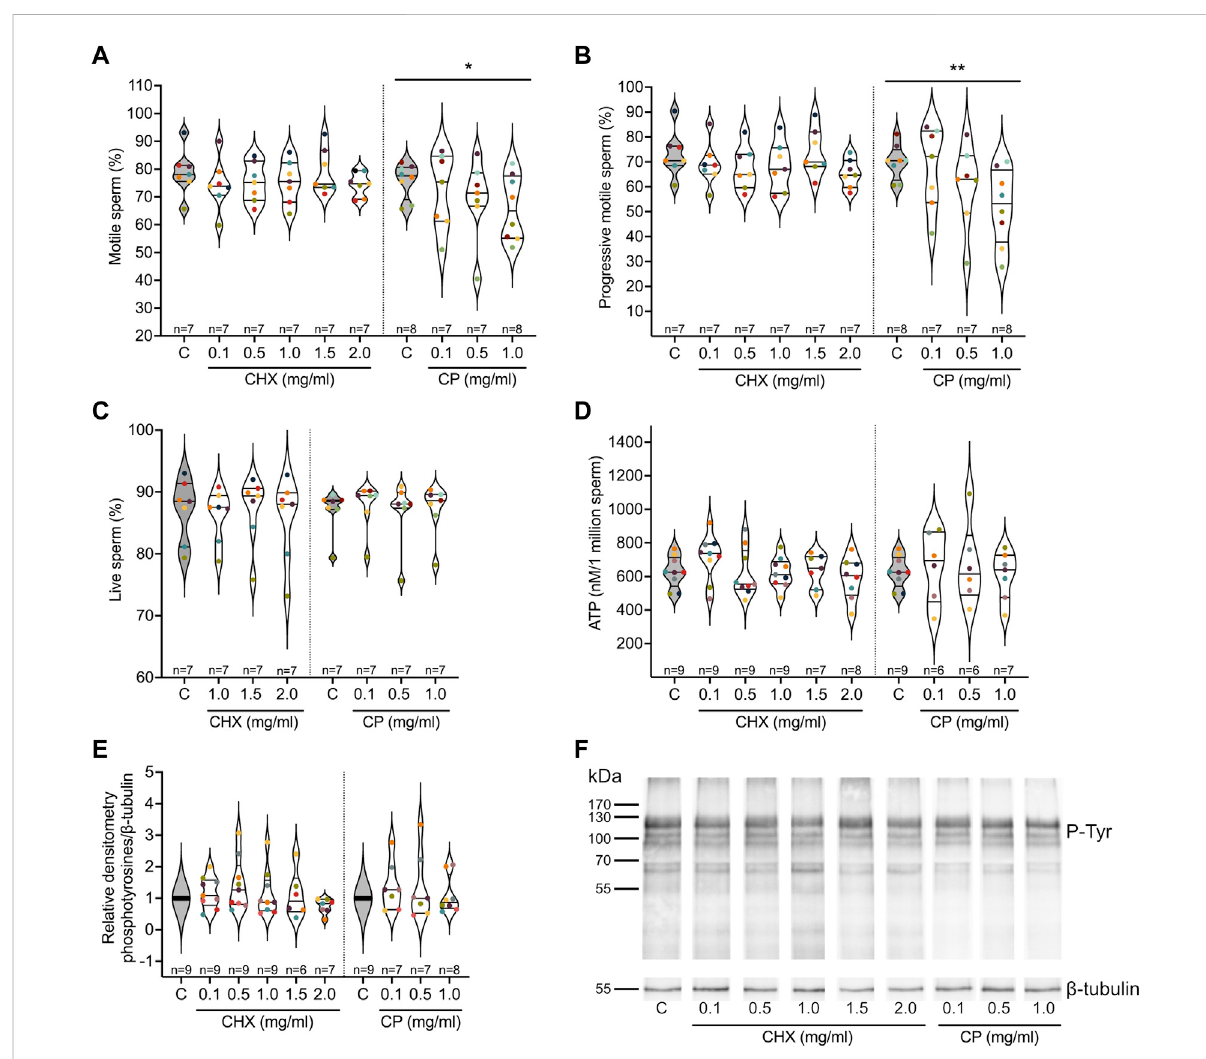
FIGURE 3 In fl uence of cytoplasmic (cycloheximide, CHX) and mitochondrial (chloramphenicol, CP) ribosome inhibitors on sperm parameters. Puri fi ed humanspermwereincubatedfor4 hinacapacitationmediumintheabsence(control,C)orpresenceofdifferentconcentrationsofthetwotypesof ribosomeinhibitors. (A) Percentageofmotilespermatozoa. (B) Percentageofprogressive spermatozoa. (C) Percentageoflivespermatozoa. (D) ATP content per million of spermatozoa. (E) Quanti fi cation of the level of phosphotyrosilated proteins in relative densitometry in respect to β - Tubulin. (F) Representative image of a Western blot analysis of phosphotyrosilated proteins used in (E) . Excepted in E, results are presented as violin plots from each condition (i.e., spermatozoa incubated in the presence of different concentrations of ribosome inhibitors). The value for